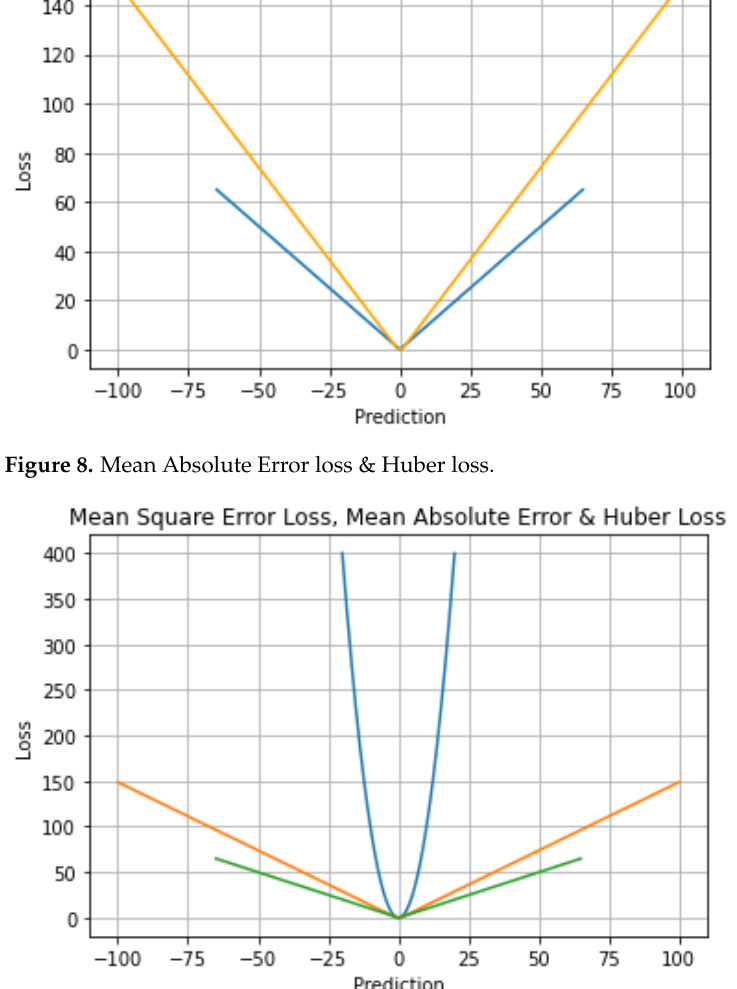
Figure 9. Mean Square Error loss, Mean Absolute Error loss & Huber loss.